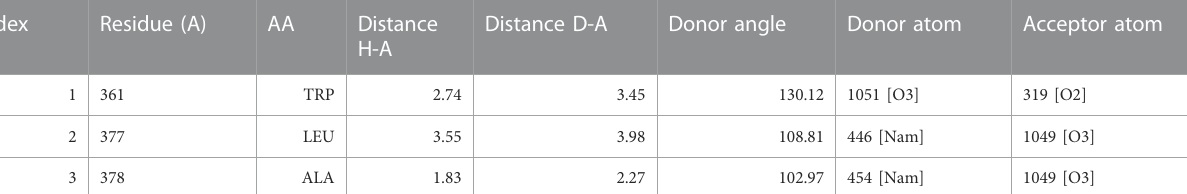
TABLE 4 Hydrogen Bonds angle between docking complex atoms Index Residue AA Distance H-A Distance D-A Donor Angle Donor Atom Acceptor